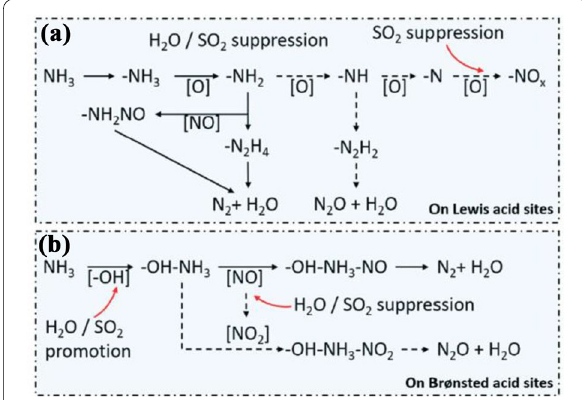
Fig. 6 Proposed mechanism of NO reduction and N 2 O formation, as well as H 2 O/SO 2 suppression effects, with the participation of a Lewis acid sites and b Brønsted acid sites over the Mn/Ti–Si catalyst [43]